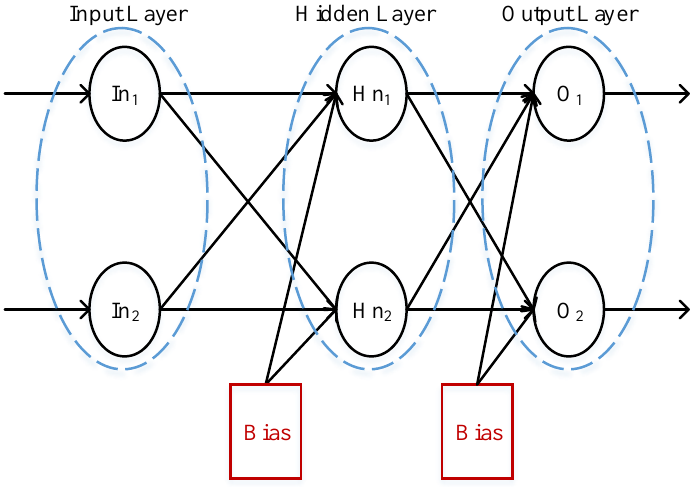
Figure 1. General FNN structure for